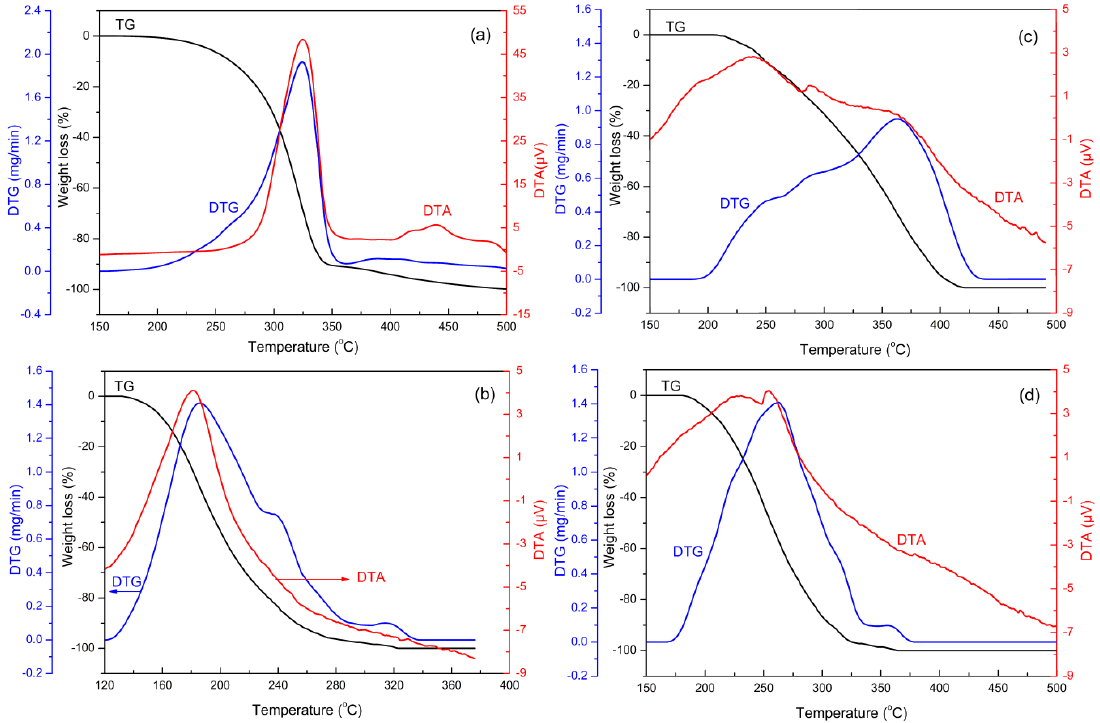
Figure 2. Simultaneous TG-DTA-DTG curves for simulating the catalytic performance for the combustion of SOF on ( a ) without catalyst; ( b ) CeO 2 ; ( c ) TiO 2 and ( d ) TiO 2 -CeO 2 catalysts.